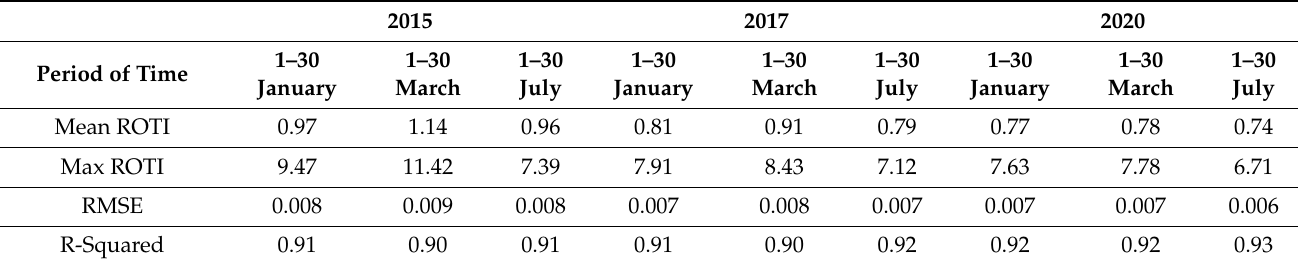
Table 3. The difference between observed and GANN-modeled ROTI during the 30 days for January, March, and June in